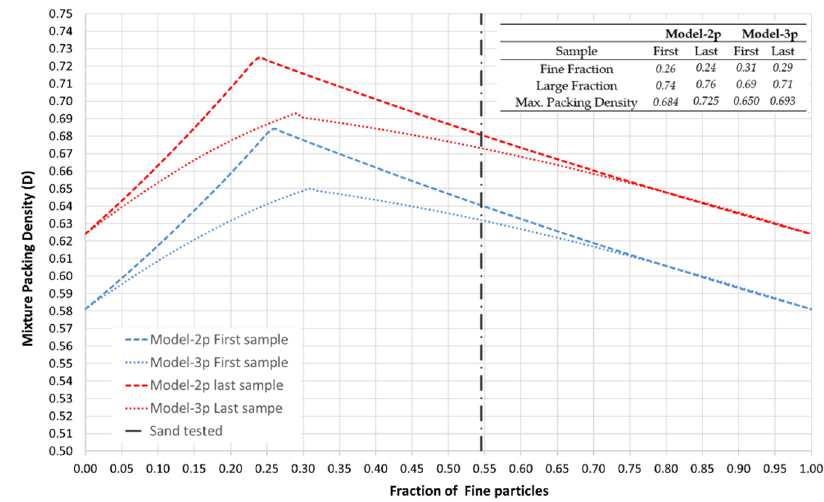
Figure 9. Variation of the mixture packing density with the fraction of fine particles estimated for Model-2p and the Model-3p [35,36] assuming the type of packing corresponding to the first (first point of Series No. 1) and the last (last point of Series No. 4) samples tested. The theoretical maximum packing density and the corresponding optimum fine and large fractions are also tabulated.